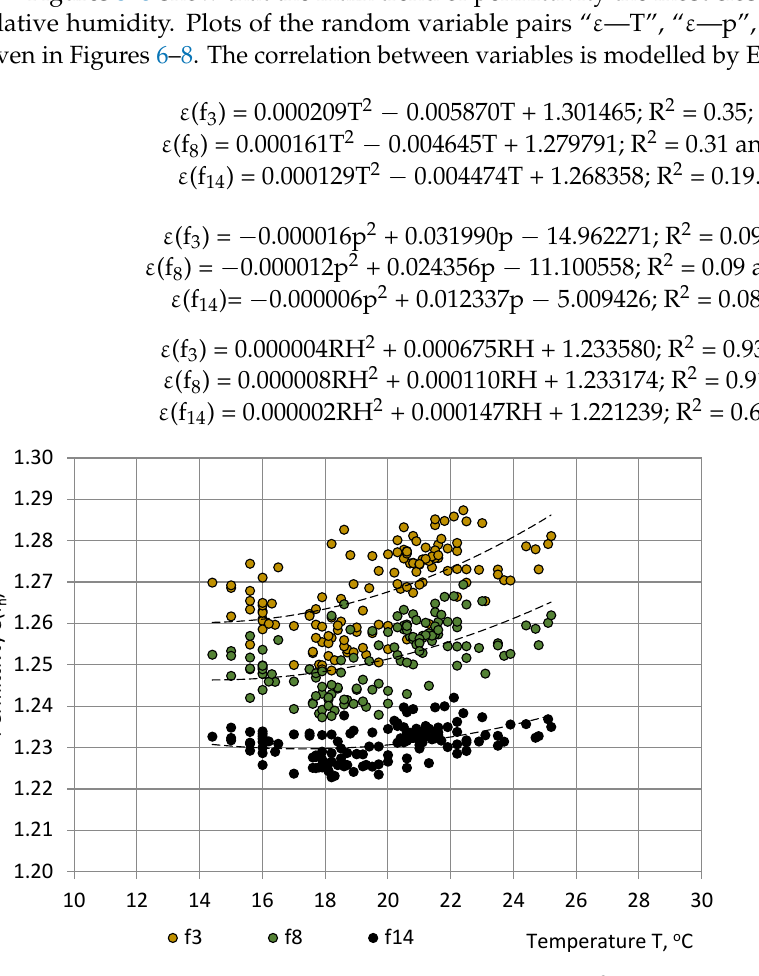
Figure 5. Atmospheric pressure p in the test room in the short series.